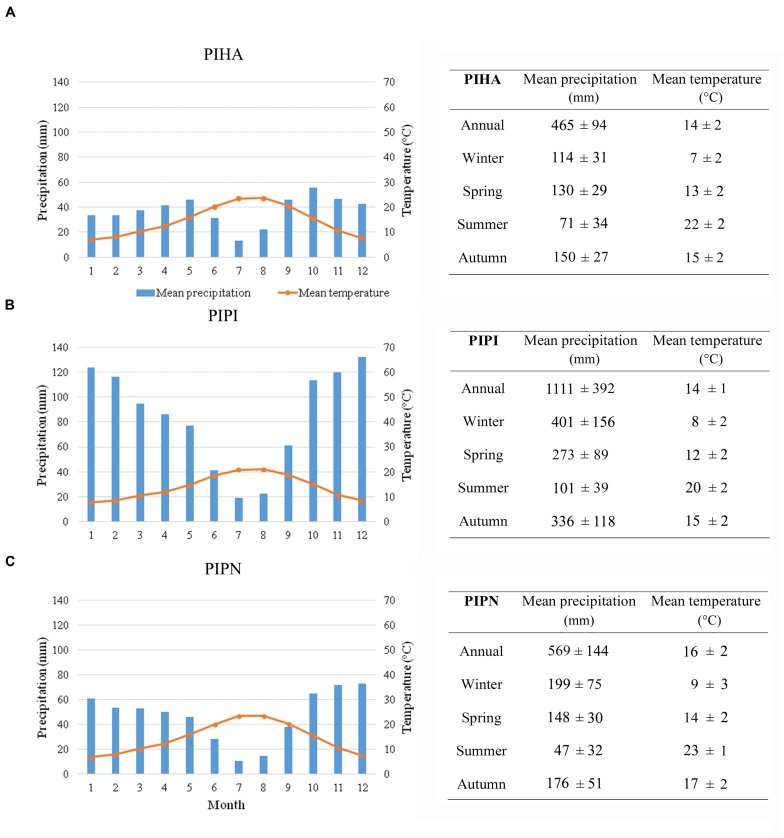
Climate diagrams and seasonal and annual values of mean precipitation and mean temperature of the sites of the network grouped by species, for the period 1901–2013 [(A) Pinus halepensis (PIHA), (B) Pinus pinaster (PIPI), and (C) Pinus pinea (PIPN)]. Data from the CRU TS v. 3.22 dataset with 0.5° grid resolution (Harris et al., 2014).